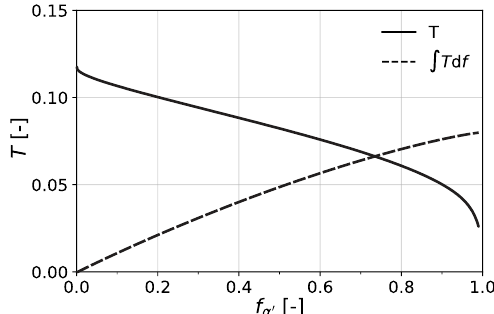
(cid:82) T d f as a function